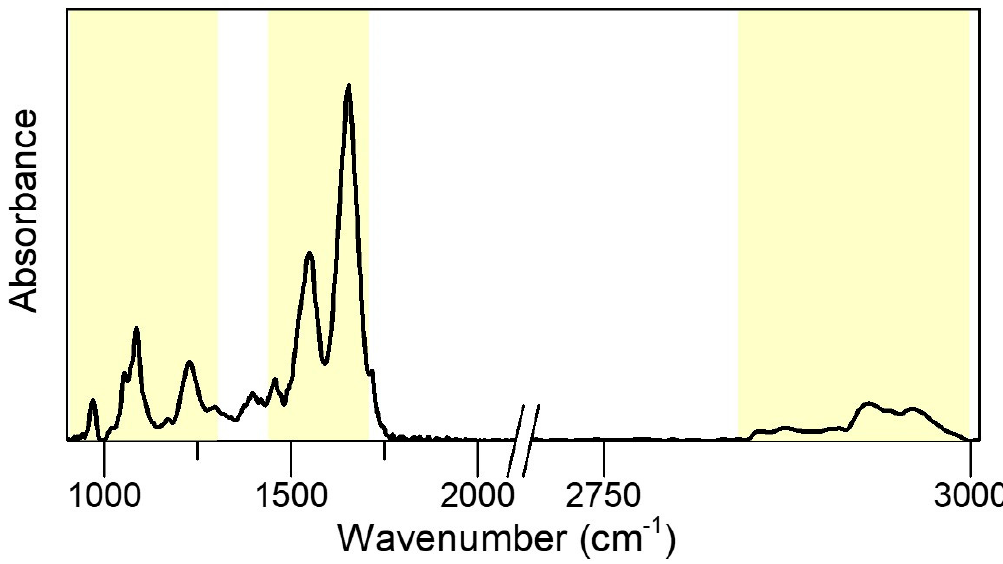
Figure 1. IR spectra: FTIR spectrum of the control sample of patient 4. Colored boxes are used to highlight the spectral regions of interests, such as 1300–900 cm − 1 , that of amide bands (1700—1480 cm − 1 ) and, finally, that assigned mainly to lipid vibrations (3000–2800 cm − 1 ).